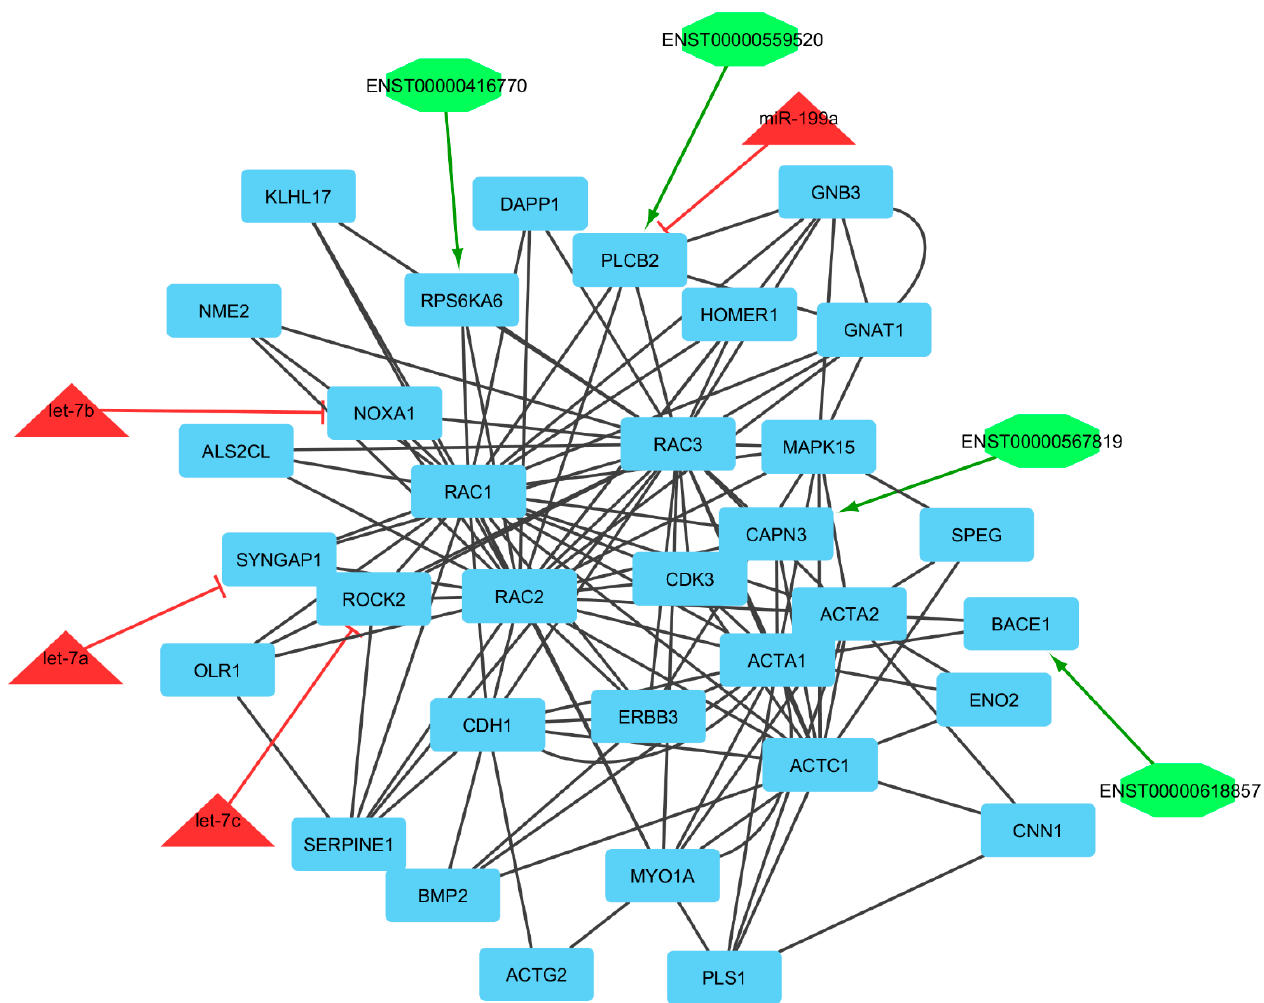
Figure 4. Module 1: 33 mRNAs/genes, 4 lncRNAs, and 4 miRNAs in an interacted network were identified. In this network, the quadrilateral nodes represent mRNAs/genes, octagonal nodes represent lncRNAs, and triangle nodes represent miRNAs. Edges indicate the interactions; black edges represent mRNA–mRNA interactions, green edges represent lncRNA–mRNA interactions, and red edges represent miRNA–mRNA interactions.